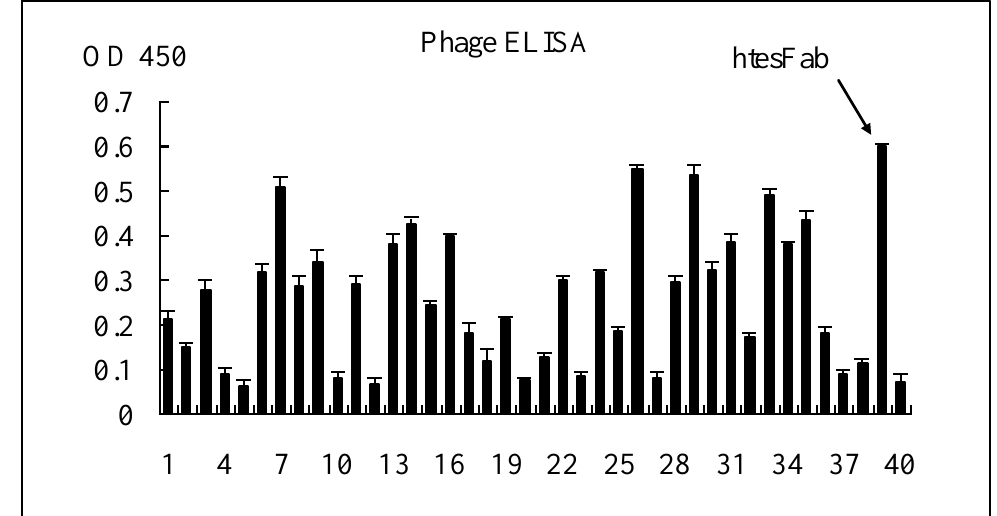
Figure 1. ELISA results of 40 individual phage clones randomly picked up from the eluted phage pool after the 3rd round of bio-panning. Purified human pLMP1-TES1 was coated at 400 ng per well, and 50 μL supernatant of each phage was added to each well for